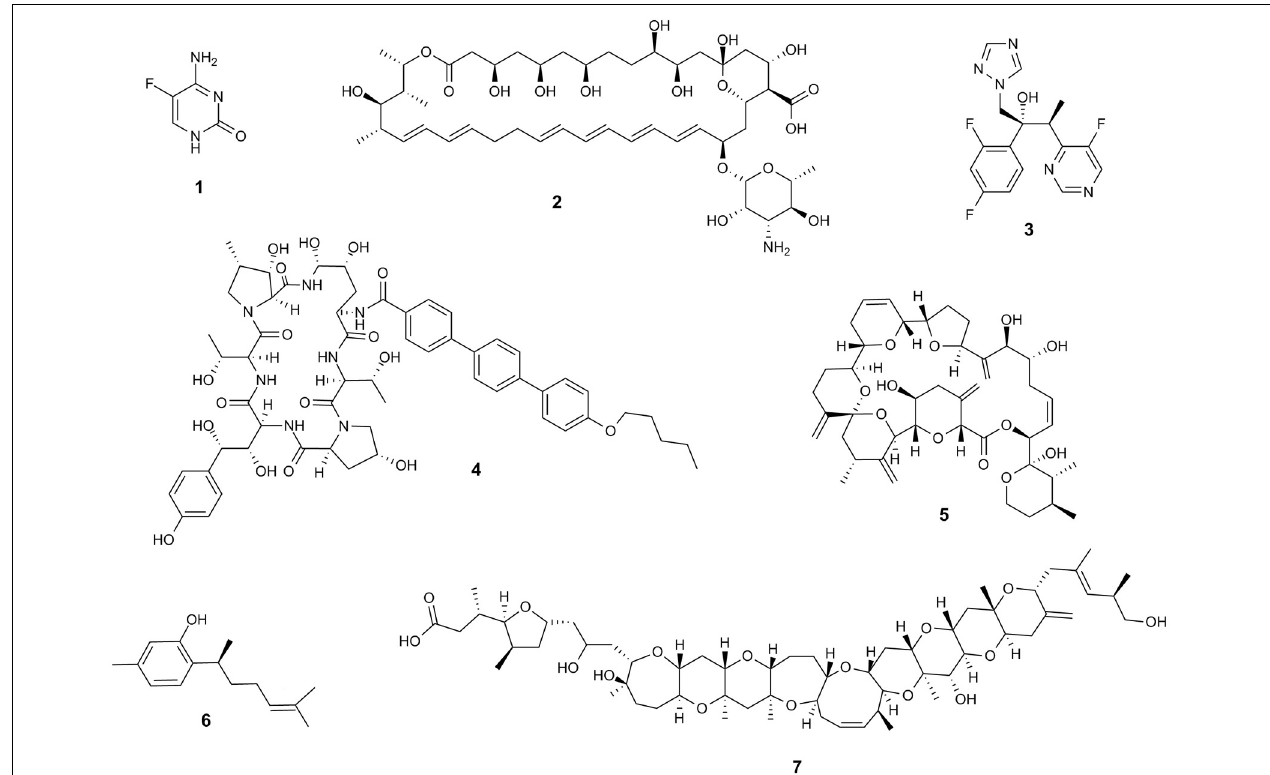
FIGURE 2 | Comparison of the structural diversity of current antifungals classes including Fluoropyrimidines (Flucytosine) (1), Polyenes (Nystatin) (2), azoles (voriconazole) (3),